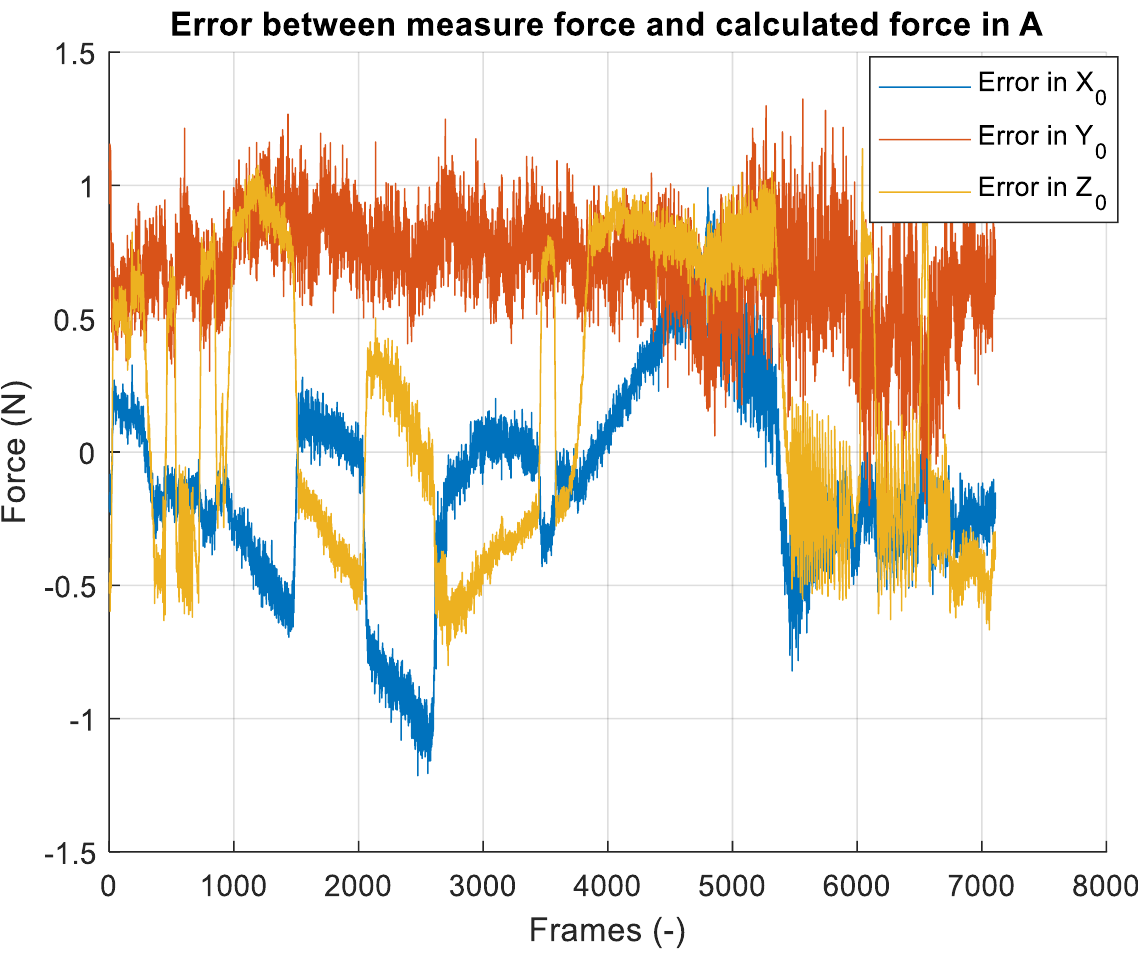
Figure 7. Error between the force measured by the sensor and the force calculated at point A. To check the correct running of calculation of the manipulator’s end point, a known mass has been applied at the end point, O 5 , and it has been checked if the method could solve the correctly applied force (Table 3), with an acceptable error (Figure 8). Table 3. Identification of the extra mass applied at the end of the manipulator.